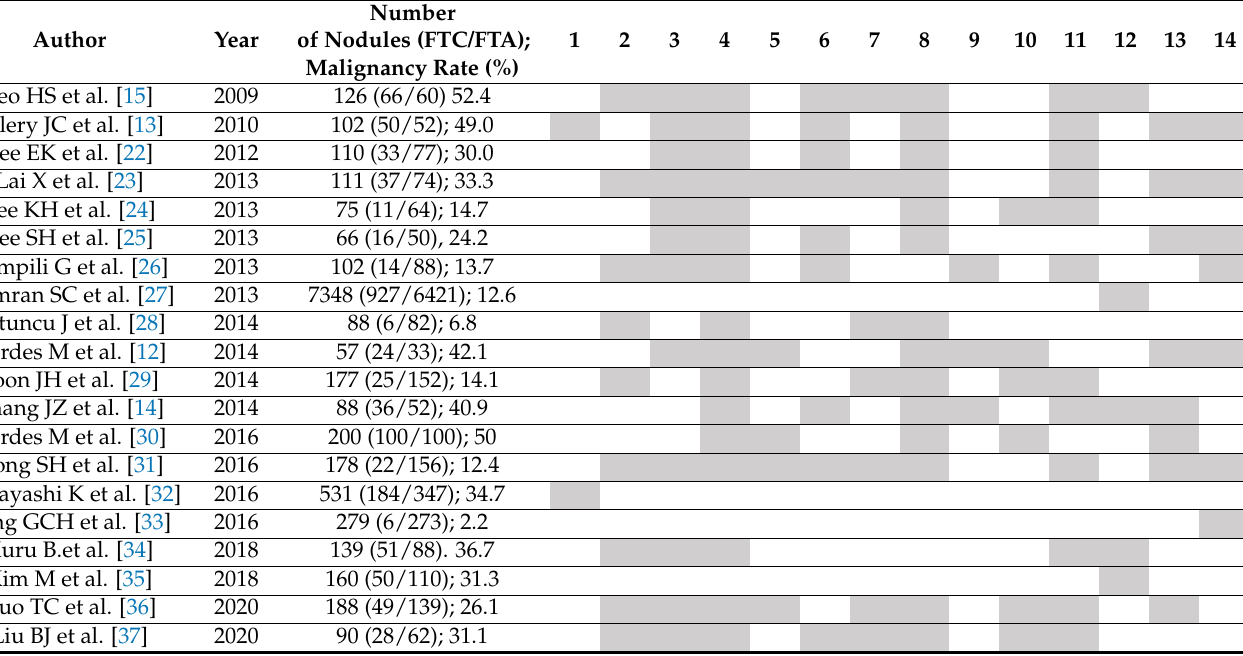
Figure 1. Methodological flow diagram of the meta-analysis for sonographic features differentiating follicular thyroid cancer from follicular adenoma utility. Table 1. The list of included studies.